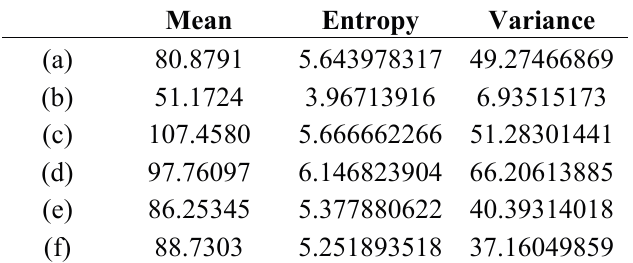
Table 2. Mean, entropy, and variance values of four images in Figure